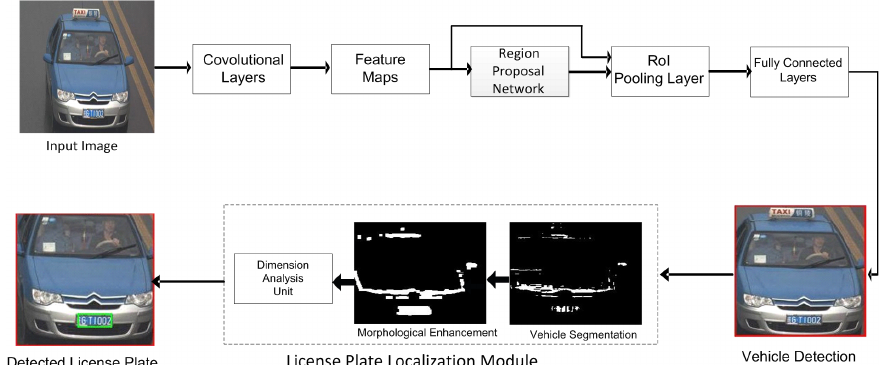
Figure 1. Block diagram of proposed